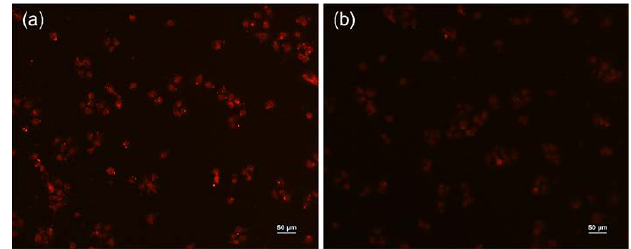
Figure 5. ( a ) The CLSM image of intracellular drug release in cancer cells; ( b ) The CLSM image of intracellular drug release in normal cells.